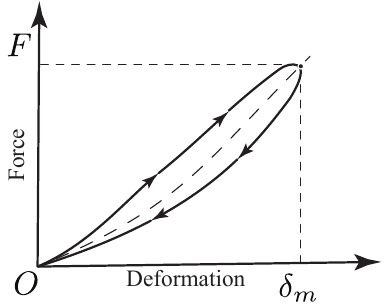
Figure 2. Hunt and Crossley: Indentation force hysteresis loop [41], where the area of such a loop represents the energy